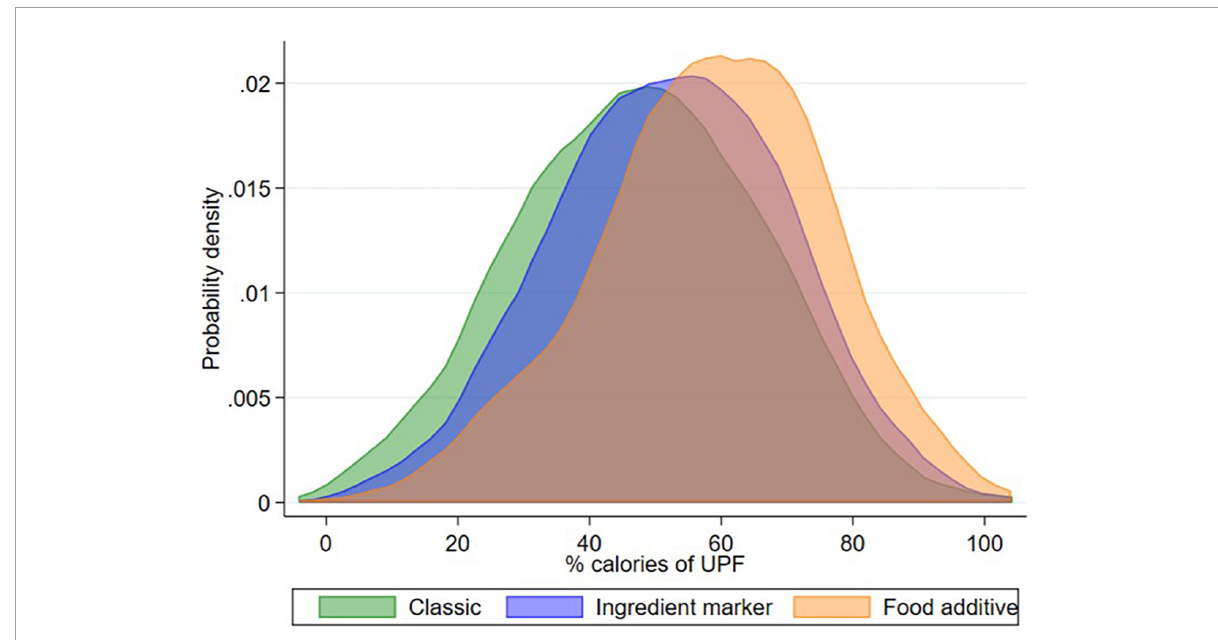
FIGURE2 Probability density of caloric share of UPF in preschoolers’ diet using three methods to identify UPF. Food Environment Chilean Cohort (FECHIC) ( n = 958). In “classic method,” UPF was identified by using food description; in “ingredient marker method,” by searching for substances not commonly used in traditional recipes and names of functional classes of “cosmetic” additives in the lists of ingredients; and in “food additive method” by searching for UPF ingredient markers, names of functional classes and all individual names of “cosmetic”